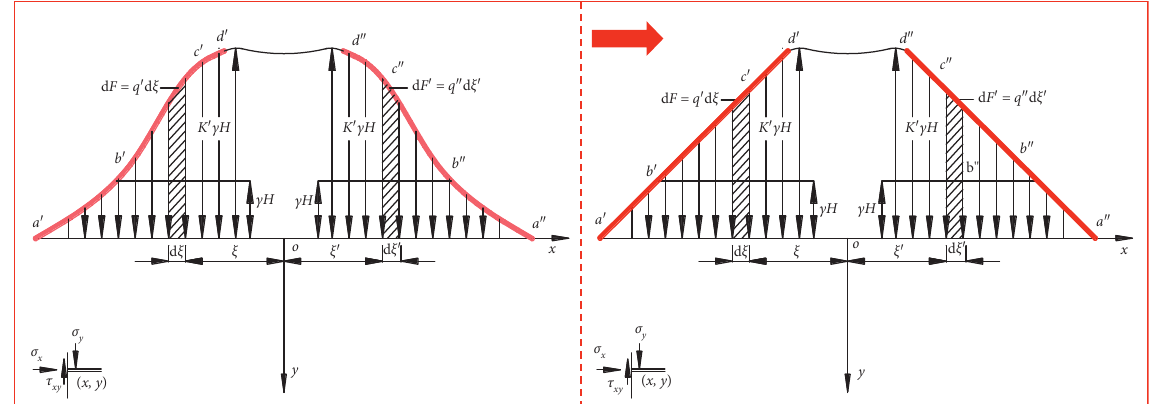
Figure 12: Diagram of the simplified stress